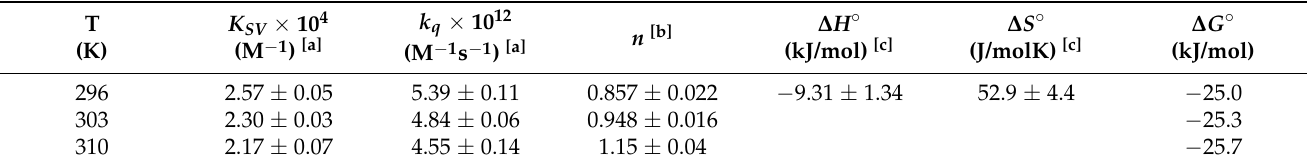
Table 1. Binding parameters for the interaction HSA:4-TPyP in PBS (pH = 7.4) at three different